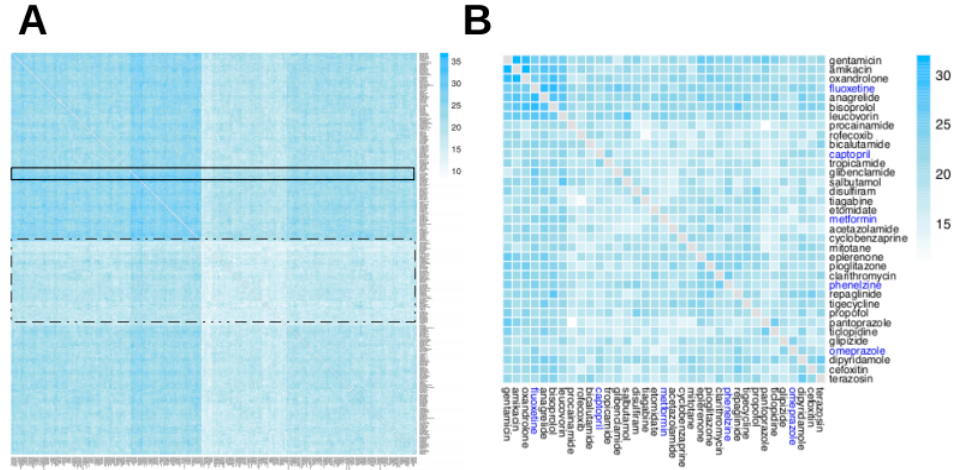
Figure 6. Heatmap of two-drug combination composite risk modules (CRMs). A CRM is a set of GO terms and cADRs that are independently associated in such a way that the manifestation of a cADR in the CRM may only be associated with the perturbation of GO terms in the same CRM. The manifestation of more than one cADR from the same CRM may then be thought to be associated with the perturbation of the same set of GO terms. The heatmap is organized using a hierarchical clustering. ( A ) The complete heatmap, containing all 315 drugs. A narrow band of drugs that exhibit the highest number of CRMs is highlighted (inside a solid line rectangle), as well as a wide band of drugs with a low number of CRMs (inside the dotted line rectangle). ( B ) A subset of the heatmap, containing 35 drugs: five drugs highlighted in blue, which are used in examples in the Discussion section, and the six drugs most similar to each of them (in terms of number of CRMs) from Panel A. It must be noted that the heatmaps presented here were generated for two-drug combinations only for simplicity in terms of the illustration of the model. It is possible to use this framework to describe any number of n -drug combinations, which will be exemplified in the Discussion